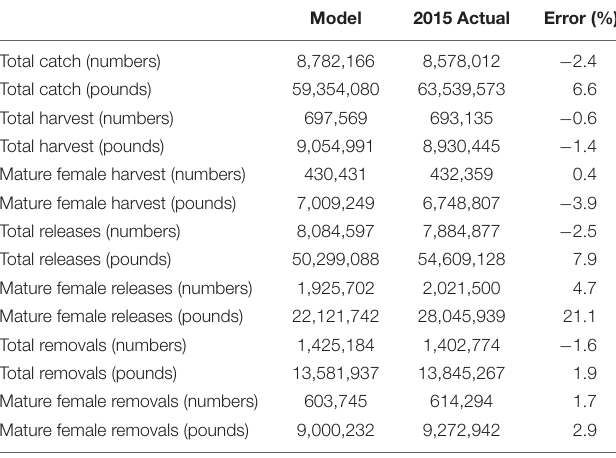
TABLE 5 | Simulation model calibration